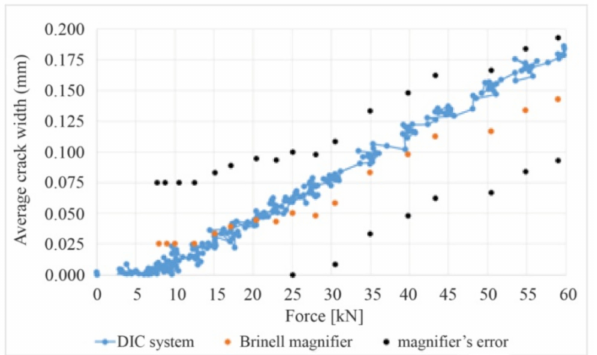
Figure 17. Average crack width from two measurement methods.